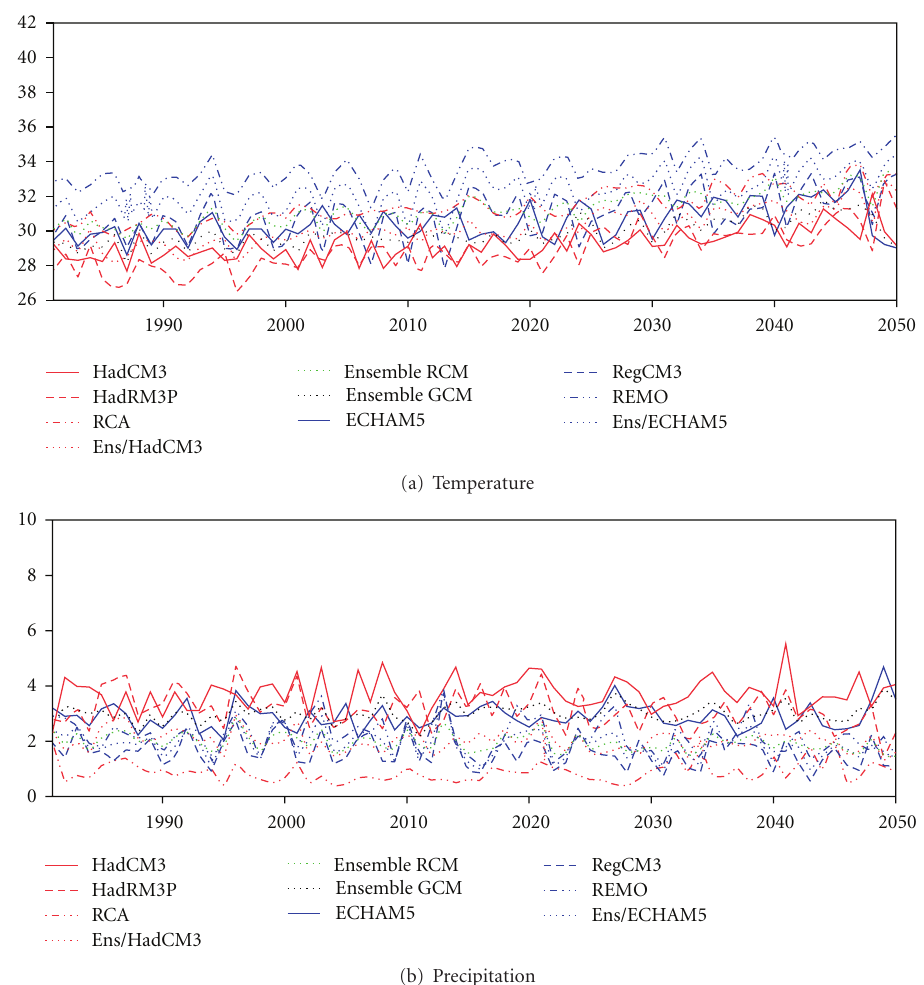
Figure 15: 1981–2050 trend of (a) temperature (in ◦ C) and (b) precipitation (mm/day) by GCMs, RCMs, the ensemble means and multi- model ensemble mean of GCMs and RCMs over Western